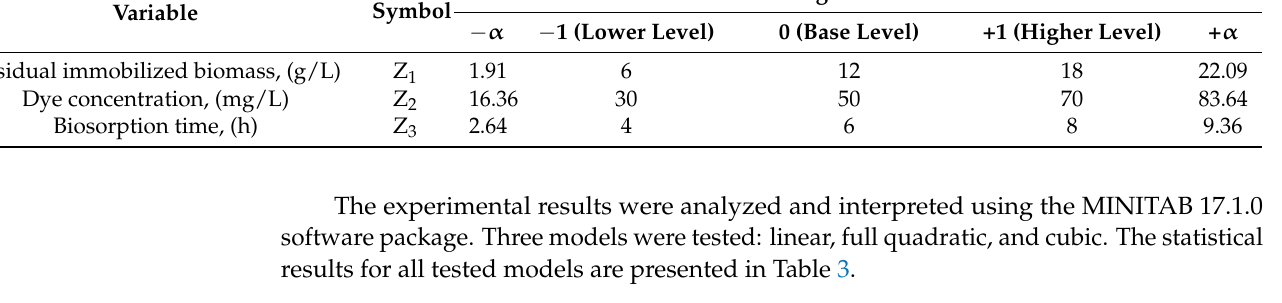
Table 3. Model summary of analysis using MINITAB 17.1.0